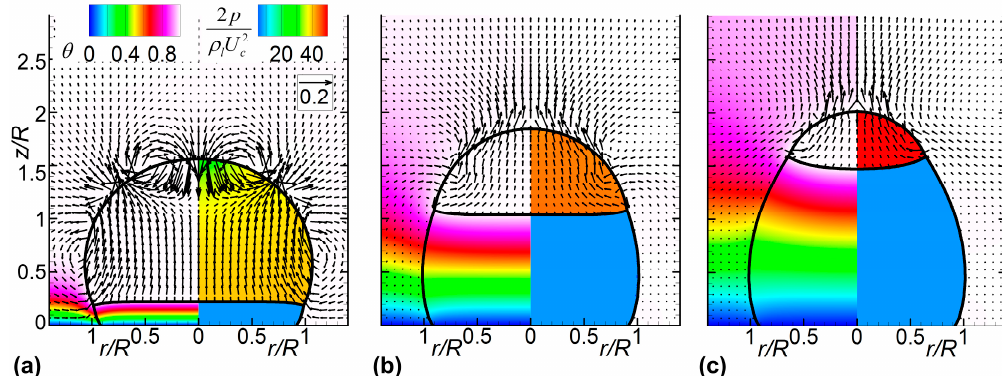
Figure 3. Evolution of the solidifying front with the temperature (left) and pressure (right) fields at ( a ) τ = 0.2, ( b ) τ = 5.0, and ( c ) τ = 9.24. The velocity is normalized by U c . The parameters are ρ sl = 0.9, φ 0 = 120° and φ gr = 12°.